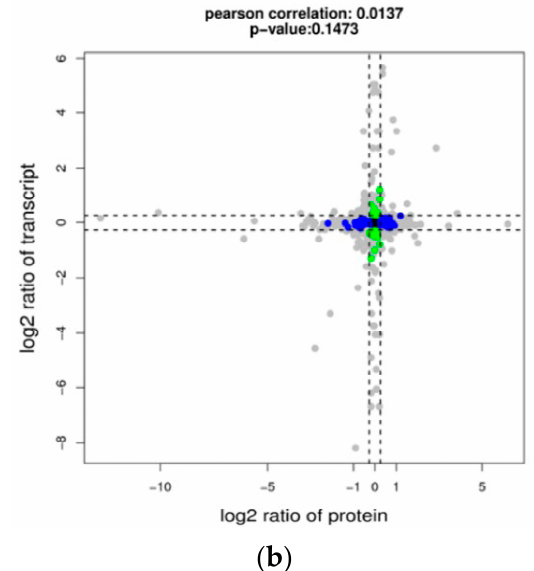
Figure 3. Combination analyses involving the transcriptomic and proteomic data identified differ- ential expression of the various genes and proteins. ( a ) Venn diagram of the combined analyses of transcriptomic and proteomic data; the overlap indicates the commonly expressed molecules at the mRNA and protein levels. ( b ) Nine-quadrant map of combination analyses of the transcriptomic and proteomic; the abscissa is the fold change (Fc) of the protein (log 2) and the ordinate is the Fc of protein (log 2). The top panel of the map shows the Pearson correlation and p -value. Each point represents a specific gene or a protein: a black point indicates non-differentially expressed proteins and genes, a green point means differentially expressed in the gene but not in protein, a blue point indicates expressed in protein but not in the gene, a gray point means that the condition of Fc > 1.2, p > 0.05 is